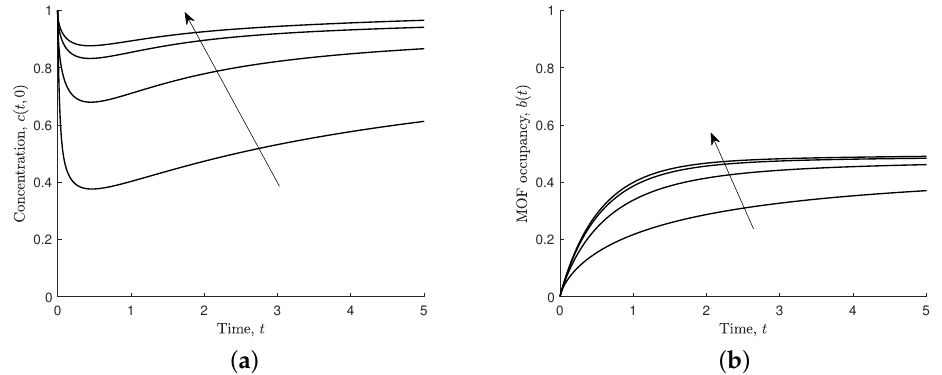
Figure 5. Results for different values of non-dimensional diffusion, s 1 = 0.1,1,5,10, and s 2 = s 3 = s 4 = 1. Arrows indicate the direction of increasing s 1 . ( a ) Non-dimensional concentration of ferric ions at MOF–polymer boundary, c ( t ,0 ) . ( b ) Non-dimensional MOF occupancy, b ( t )